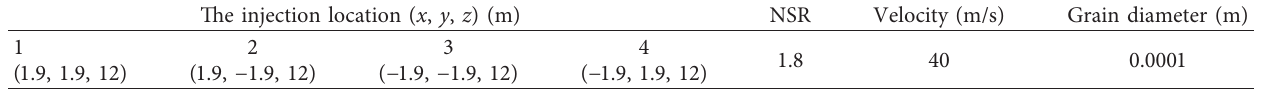
Table 5: Parameter settings of SNCR.